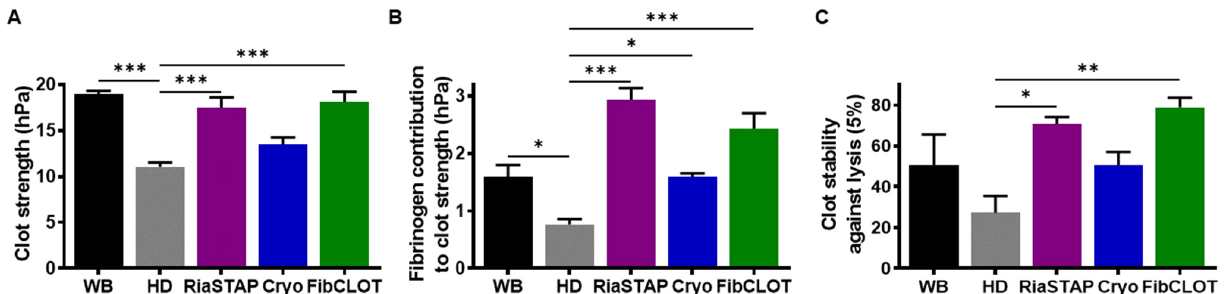
Figure 7. Clots formed after hemodilution are stabilized by fibrinogen supplementation. Whole blood or 40% hemodiluted (HD) blood spiked with cryoprecipitate, RiaSTAP ® or FibCLOT ® (1 mg/mL), and tPA (2.5 nM) was run on a QStat ® cartridge using a Quantra ® Haemostasis Analyzer. ( A ) Clot strength, ( B ) fibrinogen contribution to clot strength and ( C ) clot stability against lysis. Data represent mean ± SEM * p < 0.05, ** p < 0.01, *** p < 0.001, vs. HD. n = 3.